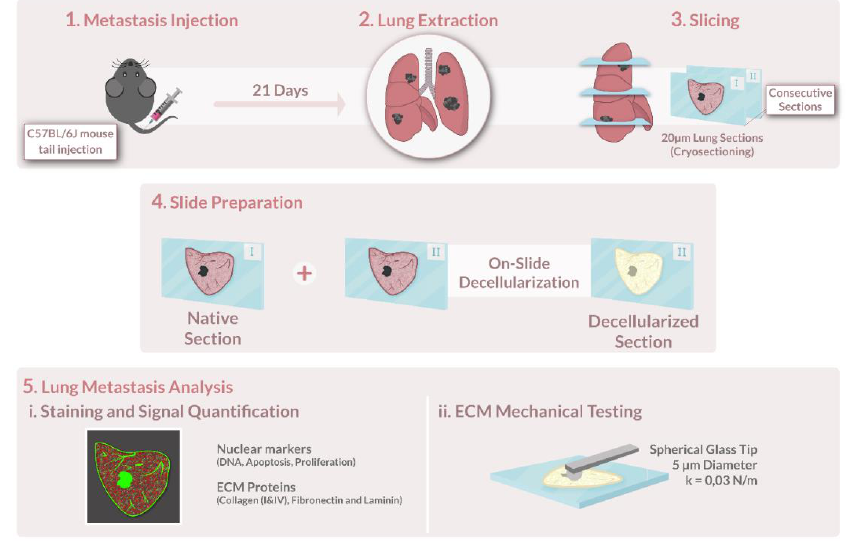
Figure 1. Schematic representation of the methodology followed in this work.